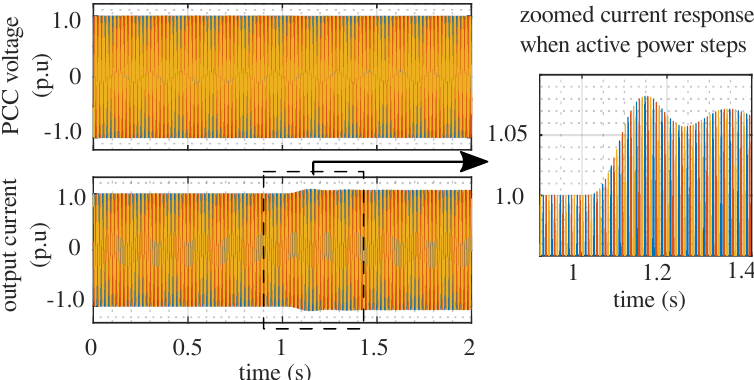
Figure 13. Simulation results of wind farm clusters connected to the weak grid where the error indicator J 2 =